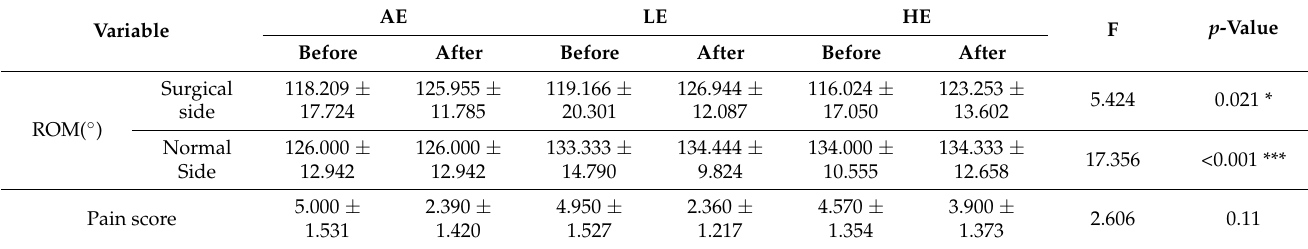
ROM, range of motion; AE, aquatic exercise; LE, land exercise; HE, home exercise. * p -value < 0.05 and *** p -value < 0.001. Values are expressed as the mean ± standard deviations. Covariate: ROM; pre-surgical knee joint range of motion, pain score; pre-surgical pain